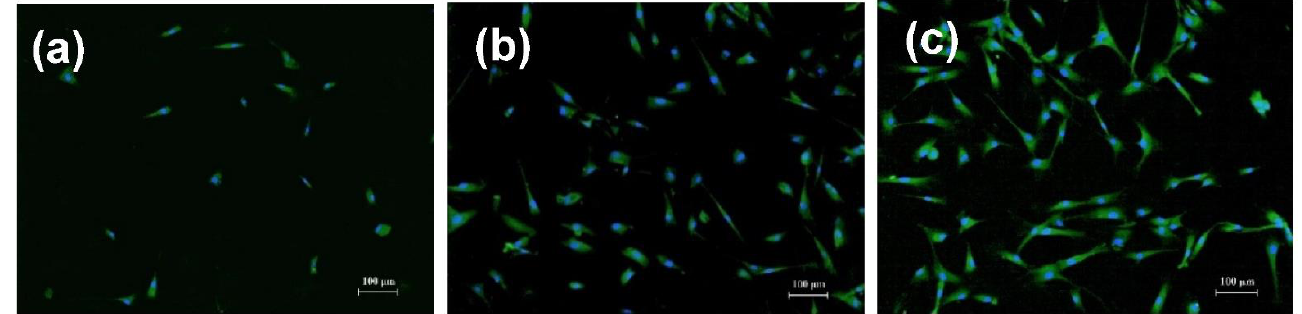
Figure 4. Fibroblasts were cultured on the surface of gel-based substrate ( a ), with 1.2% Al 2 O 3 ( b ), and with 1.2% Fe 2 O 3 NPs ( c ). Cell nuclei and the cytoplasm were stained with DAPI and pyrazolone yellow, respectively [122].